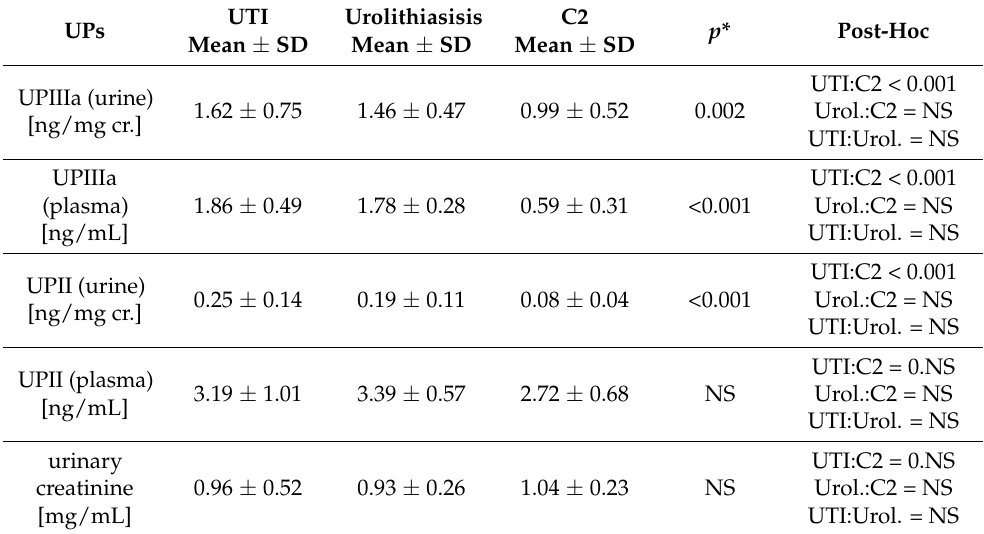
Table 3. Results for UPIIIa and UPII in patients with UTI, urolithiasis and control group C2.